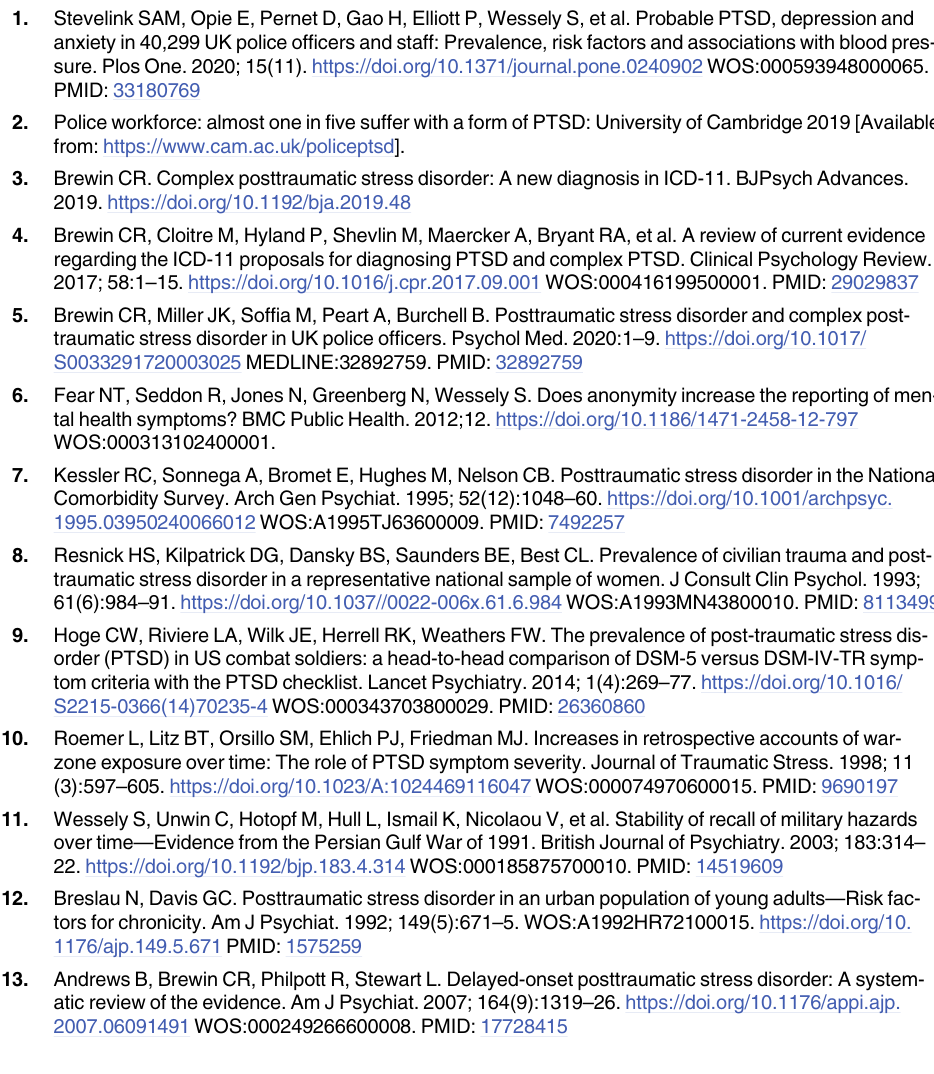
figure of 3.9% specifically reflects the prevalence of recent-onset PTSD within the entire U.K. police force. They also found, replicating the Policing: The Job & the Life survey, that 27% of those with recent traumatic events had a probable PTSD diagnosis. We have demonstrated that their data in no way contradict the recent estimate that the total PTSD and Complex PTSD prevalence in the U.K. police force amounts to 20.6% [3]. The conclusion is that it is important to distinguish carefully the nature of reported prevalence rates so as not to underes- timate the potential impact of trauma exposure on the mental health of police